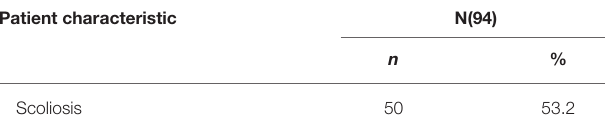
TABLE 3 | Demographic